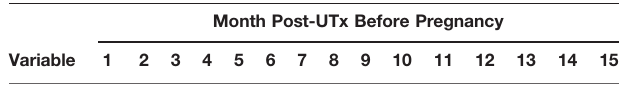
TABLE 1 | Patient management after UTx and during gestation. Table 1A Timeline for patient management between UTx and achievement of pregnancy Month Post-UTx Before Pregnancy Variable